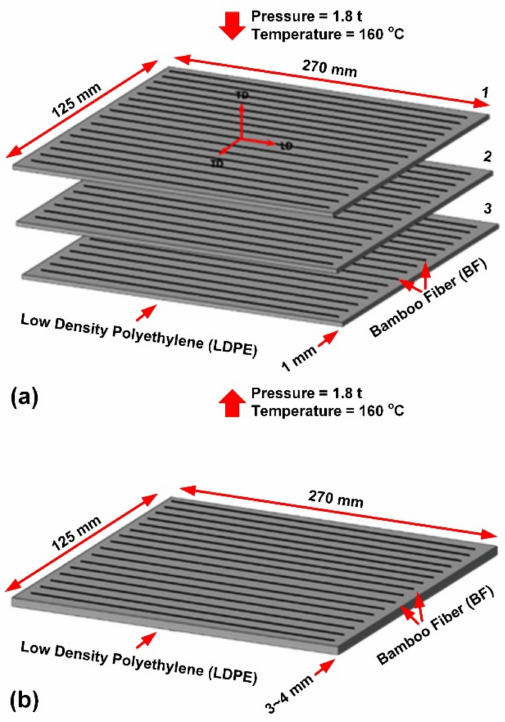
Figure 2. Dimensions of the prepregs and an example of the composite sheets used for further characterization, ( a ) prepregs in unidirectional plies and ( b ) an example of a composite sheet [0] 3